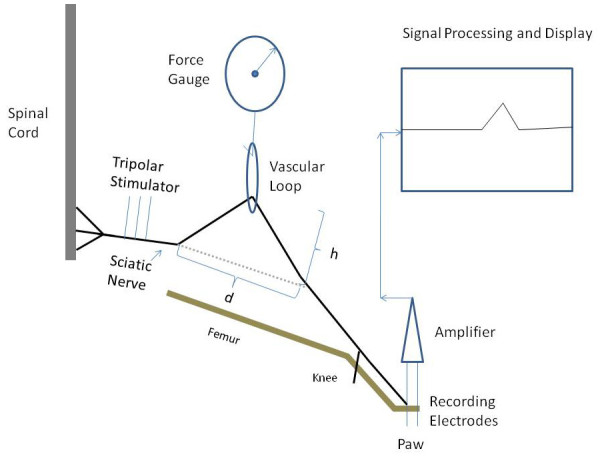
Schematic diagram of the nerve stretch experiment.